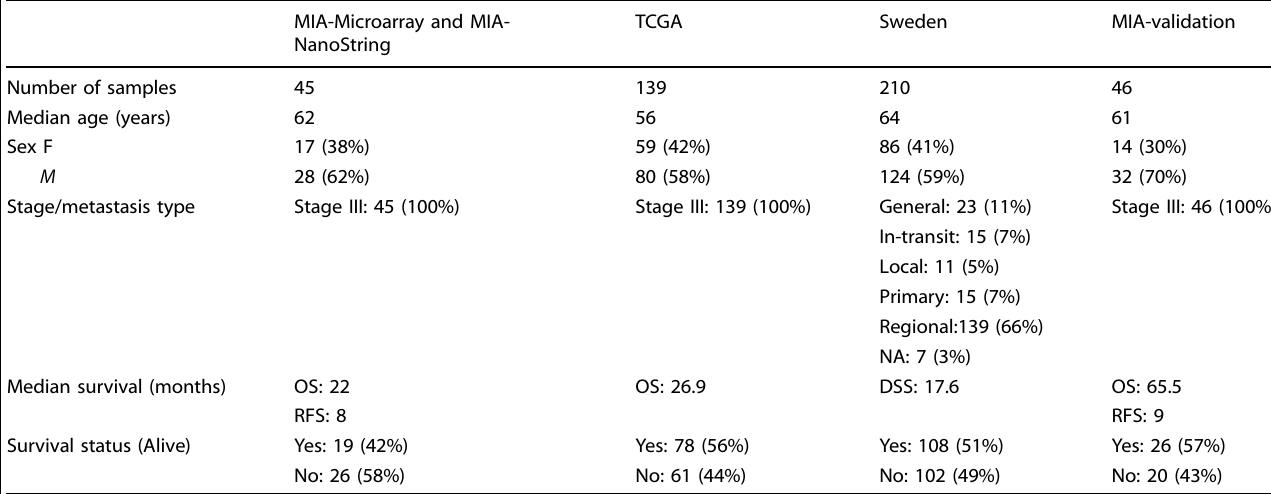
Table 1. Data summaries for fi ve melanoma datasets, MIA-Microarray, MIA-NanoString, TCGA, Sweden and MIA-Validation.